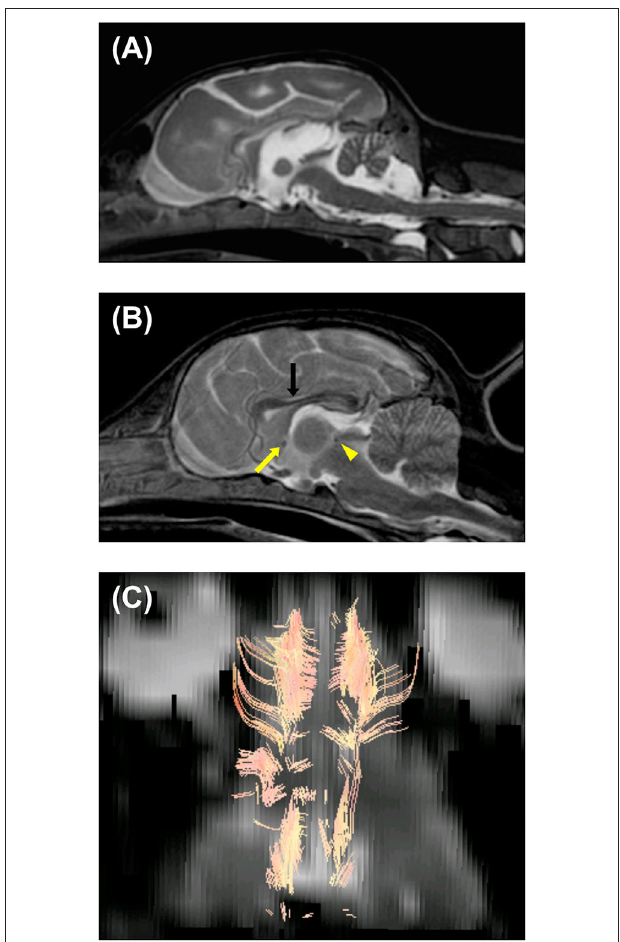
FIGURE 2 | Magnetic resonance T2-weighted imaging of the brain in the median sagittal plane of the patient (64-days-old) (A) and a normal beagle dog (73-days-old) as a similar-age reference (B) . (A) Dilation of the third and fourth ventricles, presumptive dilatation of the pineal recess or a quadrigeminal cyst, and diffuse hypoplasia of corpus callosum, rostral commissure, caudal commissure, and the ventral part of the cerebellar vermis (lingula, nodulus, and uvula of the cerebellum) are seen. The reduced size of the brainstem and cerebellum and thinning of the interthalamic adhesion are also seen. (B) Unlike the patient, corpus callosum (black arrow), rostral commissure (yellow arrow), and caudal commissure (yellow arrowhead) are clearly recognized in a normal beagle dog (73-days-old). (C) Diffusion tensor imaging (DTI) tractography of the patient’s brain. Regions of interest were placed to visualize corpus callosum. There seemed to be no visible commissural fiber across both hemispheres. This finding demonstrated hypoplasia of corpus callosum, although there is a possibility that DTI tractography may not accurately represent the white matter